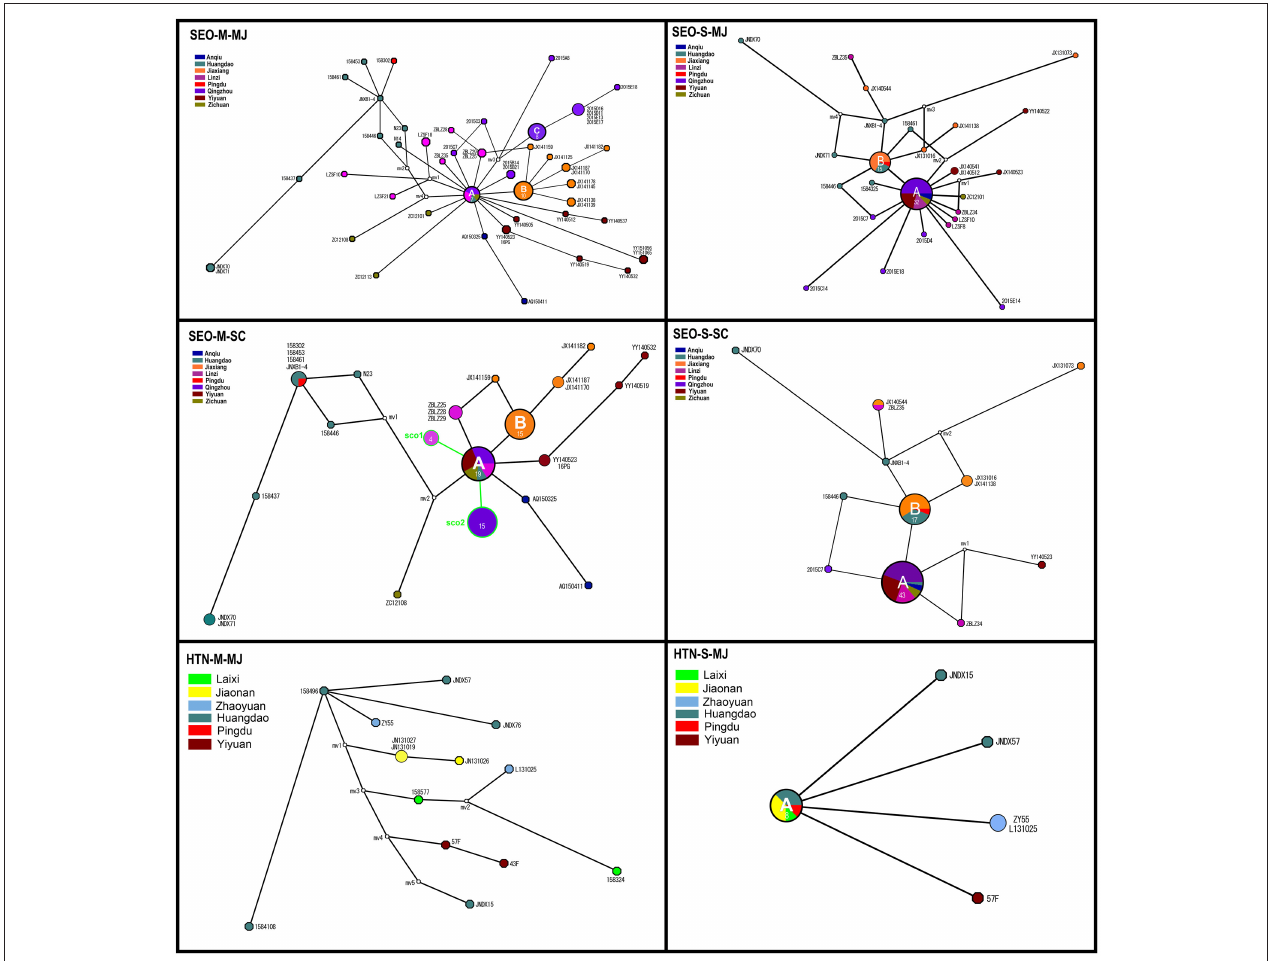
FIGURE 5 | Median-joining (MJ) and Star Contraction (SC) phylogenetic networks of Seoul virus and Hantaan virus. Each pie chart was colored according to the geographic origin of the samples and sized relative to its frequency in the dataset. The numbers in each pie chart represent the haplotypes of the strains. Small white circles represent median vectors (roughly equivalent to hypothetical unsampled haplotypes). Length of the branch is proportional to the number of mutational changes between